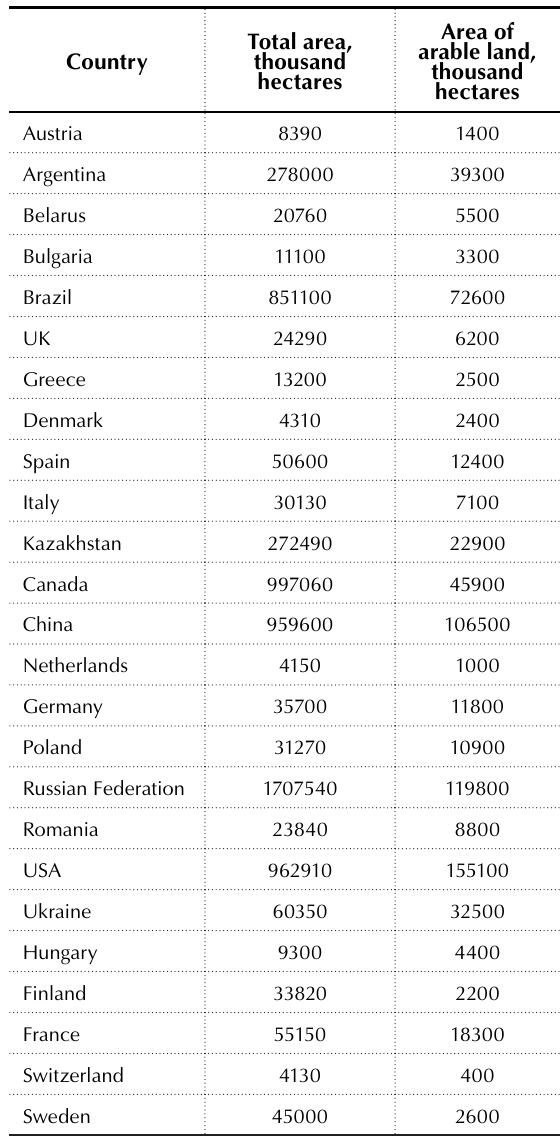
Table 1. Comparison of the total area and the amount of arable land in different countries of the